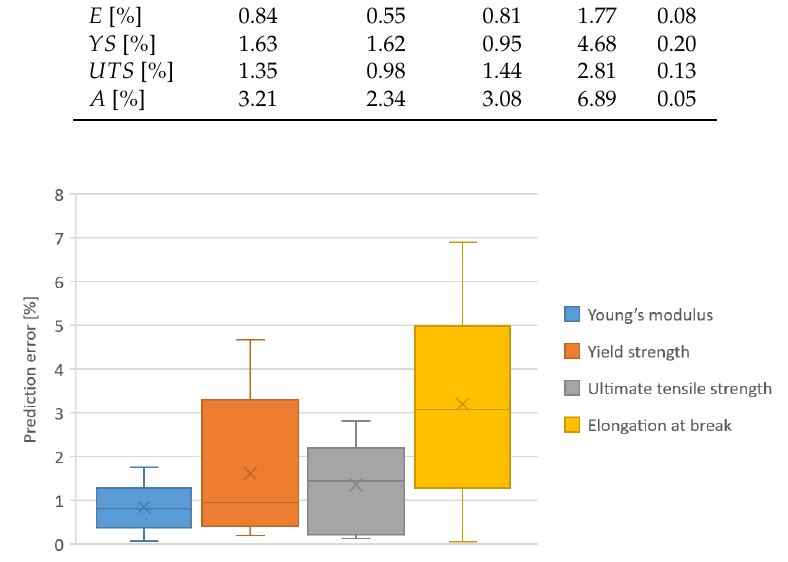
Figure 17. Prediction error for Al